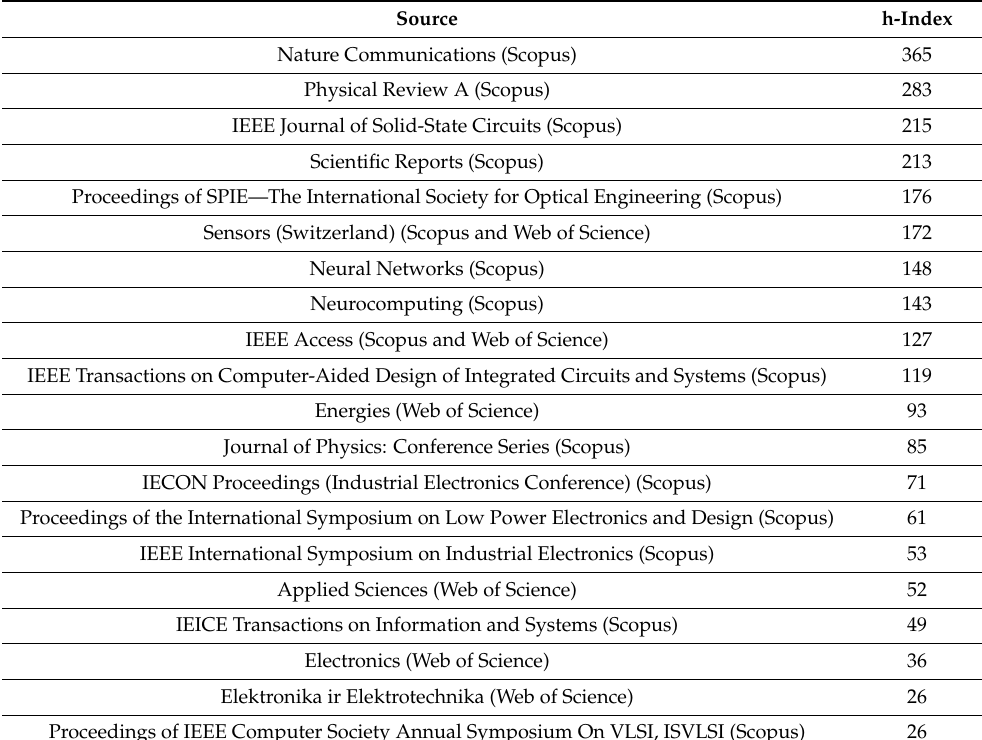
Table 1. h-index of sources according to Scopus and Web of